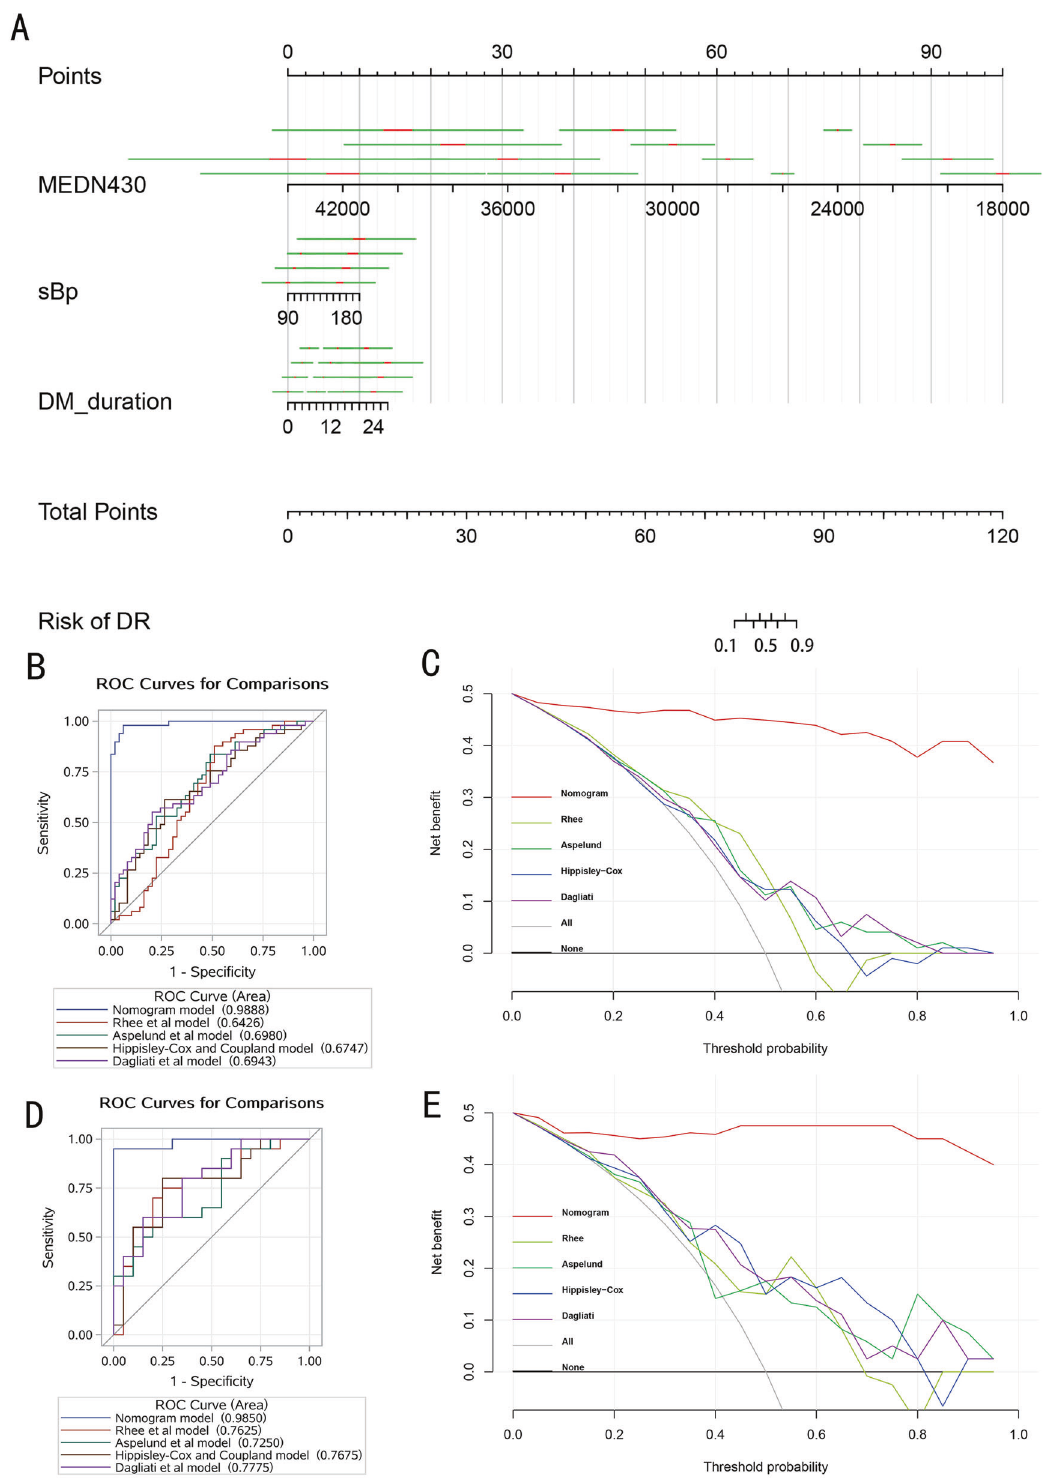
Fig. 2 Development and validation of the nomogram model. Developed nomogram for diabetic retinopathy ( A ), and the ROC curve and decision curves analysis curve of the Nomogram model, Rhee et al. model, Aspelund et al. model, Hippisley-Cox and Coupland model, and Dagliati et al. model in the training set ( B , C ) and testing set ( D , E ). Notes: nomogram model, thiamine triphosphate, systolic blood pressure, duration of diabetes; Rhee et al. model, glutamine/glutamate ratio; Aspelund et al. model, gender, systolic blood pressure, duration of diabetes and glycated hemoglobin; Hippisley-Cox and Coupland model, age, BMI, systolic blood pressure, cholesterol/high-density lipoprotein ratio, glycated hemoglobin; Dagliati et al. model, age, gender, duration of diabetes, BMI, glycated hemoglobin, hypertension, smoke; none, net bene fi t when all patients are considered as not having the outcome (diabetic retinopathy); all, net bene fi ts when all patients are considered as having the outcome. The preferred model is the model with the highest net bene fi t at any given threshold. Abbreviations: MEDN430 thiamine triphosphate, sBp systolic blood pressure, DM_duration duration of